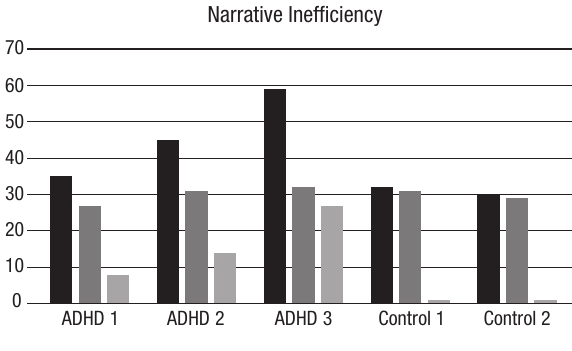
Figure 4. Narrative Inefficiency. ADHD patients used more plot nuclei than control individuals without improvement in their narratives.